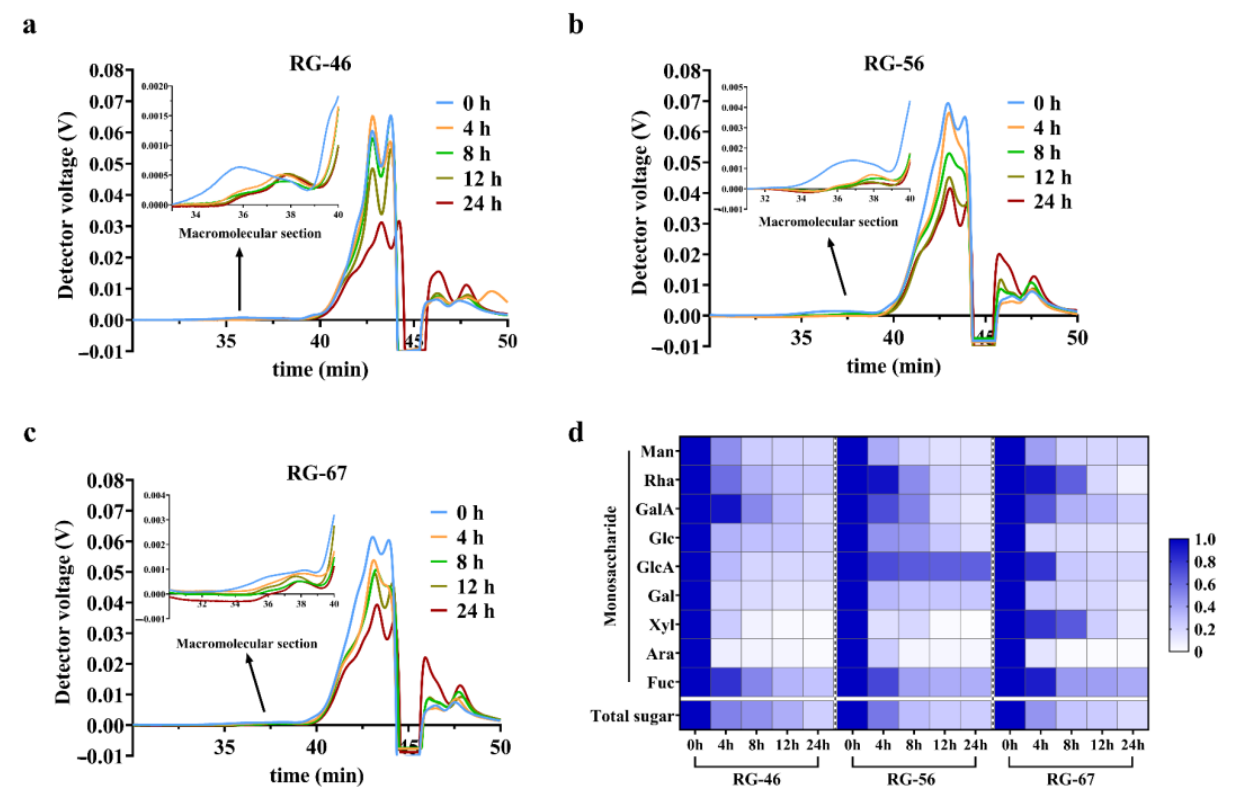
Figure 2. Consumption and degradation of three pectic polysaccharides. ( a – c ) The degree of molecu- lar weight reduction of RG-46, RG-56, and RG-67 detected by SEC-MALLS-RI; ( d ) relative ratio of total sugars and monosaccharides remaining during fermentation compared with the contents at 0 h.